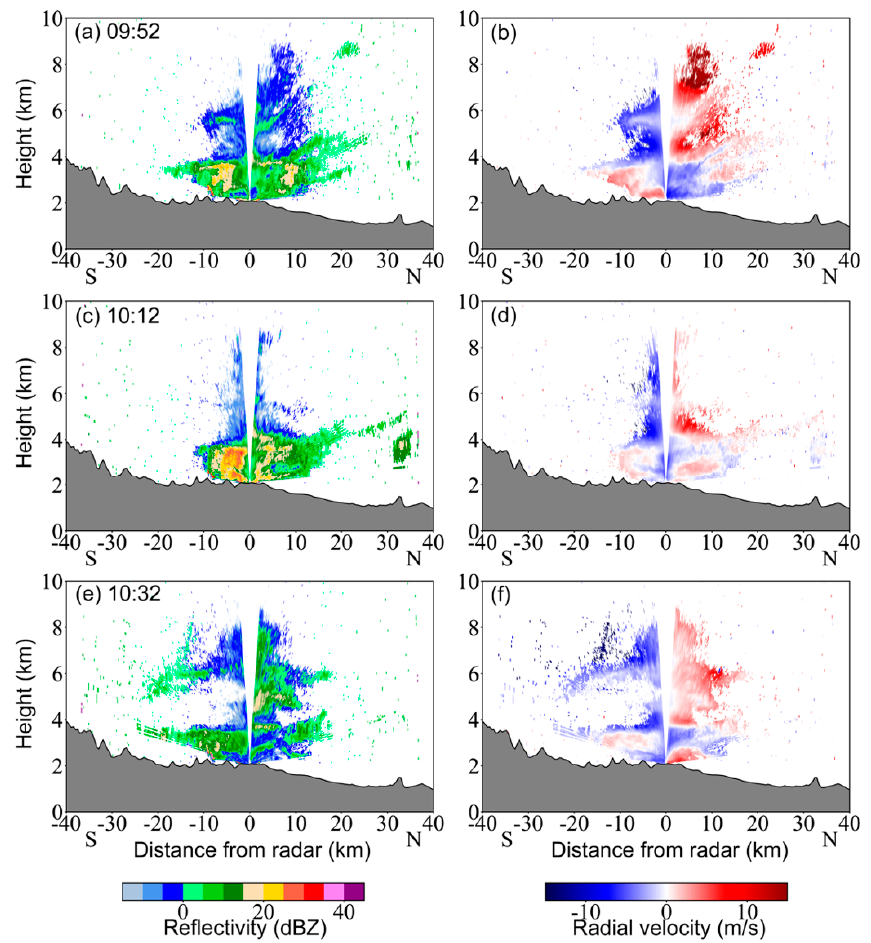
Figure 7. RHI measurements of ( a , c , e ) reflectivity and ( b , d , f ) radial velocity conducted by the cloud radar for Segment 2. S and N below each panel indicate south and north of the cloud radar. The blue color in the panels of radial velocity indicates flow towards the radar, while red indicates flow away from the radar.